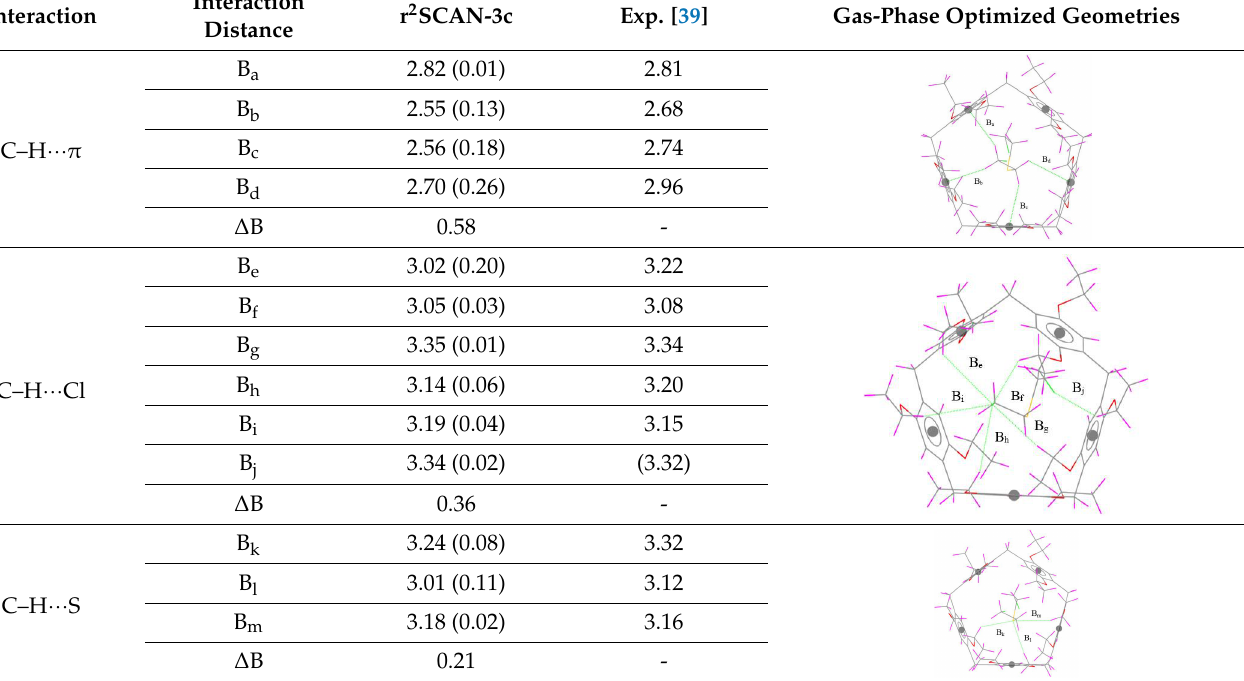
Table 1. Experimental and computed nearest intermolecular distances (Å) of SM@EtP[5] complex. (The values in brackets represent the difference between the computed and the experimental distances).